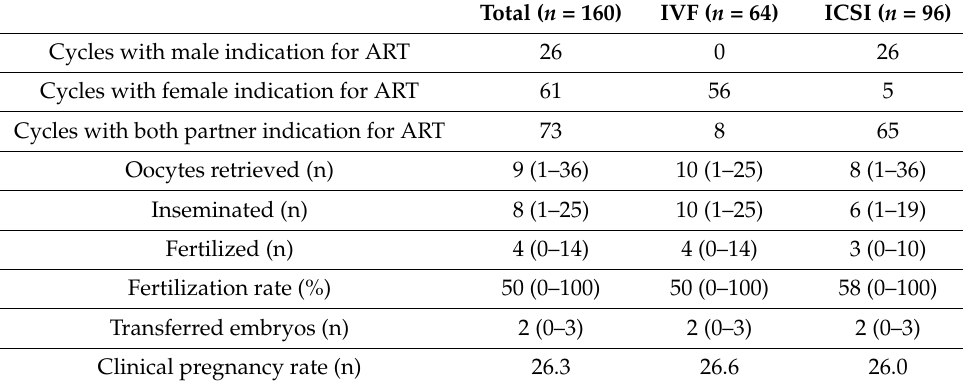
Table 3. Clinical data on the ART cycles. The minimal and maximal values are given in